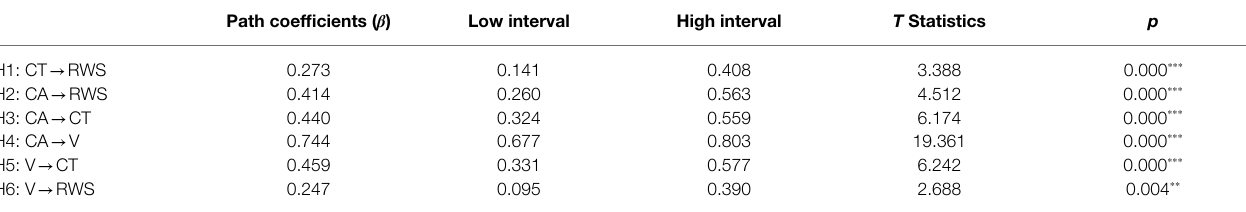
TABLE 11 | Results of the structural model. Path coefficients ( β